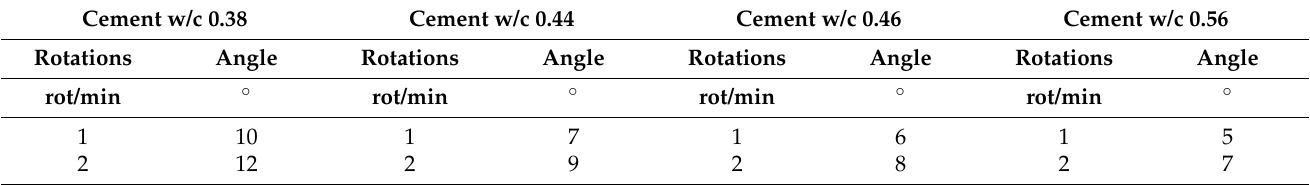
Table 1. Data from laboratory tests conducted on a Chan model 3500 viscometer (R1-B1, F1). Cement w/c 0.38 Cement w/c